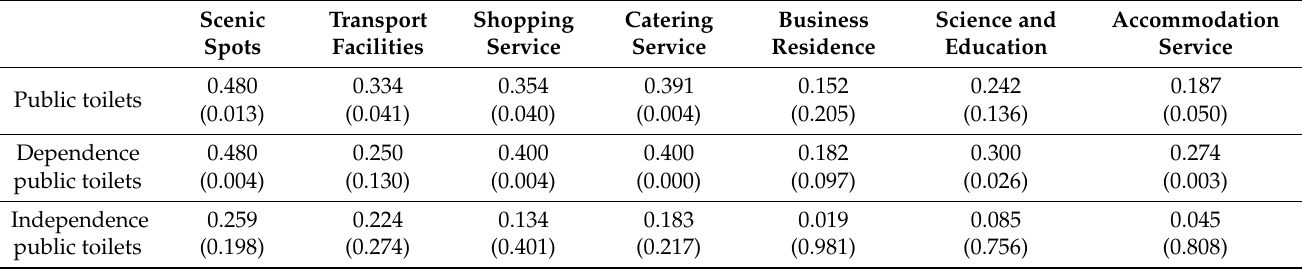
Table 3. Detection results of the factors influencing the spatial distribution of public